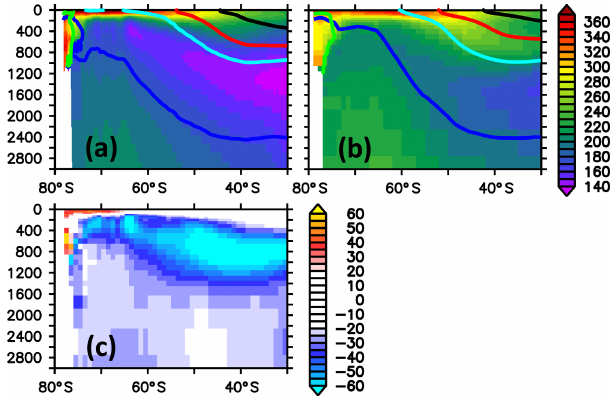
Figure 27. Zonally averaged meridional section of dissolved oxy- gen concentration in units of mmolO 2 m − 3 . Panel (a) refers to sim- ulated concentrations averaged over the nominal 1993–1998 period of the reference simulation; (b) refers to observed climatological concentrations (WOA09); (c) refers to the difference between sim- ulated and observed concentrations, with blue colors denoting mod- eled concentrations that are biased low. The thick black, red, cyan, blue and green contours refer to mean densities (Sallée et al., 2013b, their Table 2) of subtropical water, mode water, intermediate water, circumpolar deep water and bottom water, respectively.